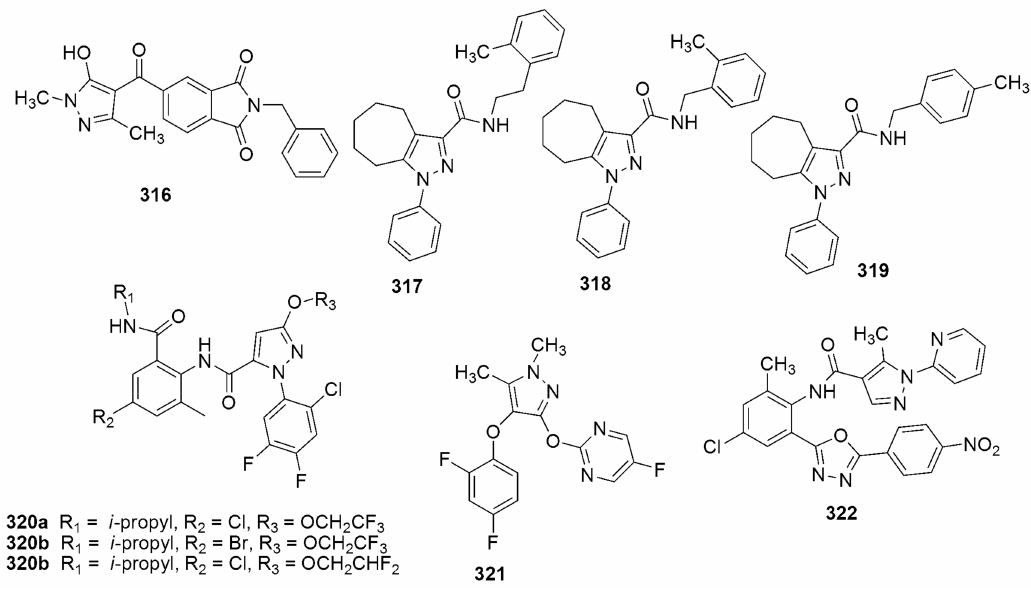
Figure 18. Structures of pyrazole a derivative acting as promising agrochemical